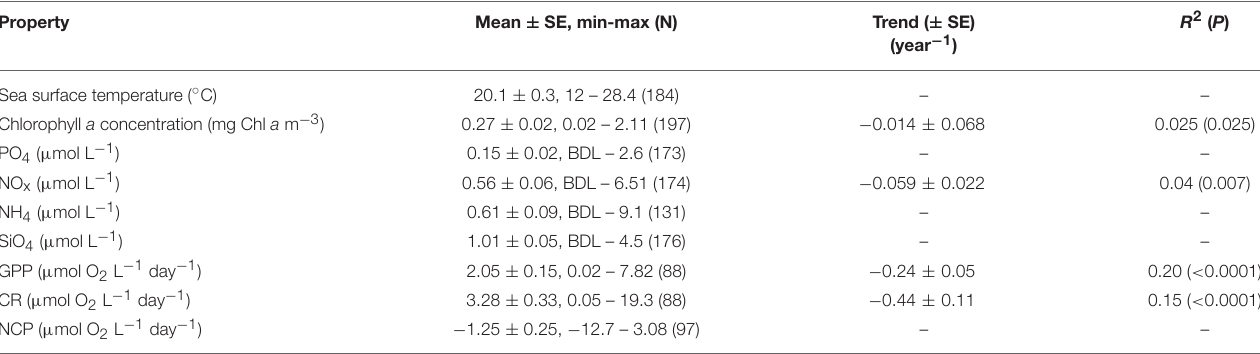
TABLE 1 | Mean ± SE, minimum, and maximum sea surface temperature, nutrient concentration, chlorophyll a concentration, gross primary production, community respiration, net community production, and the linear rates of change ( ± SE), along with the R 2 and probability of the observed linear trends, in Cap Salines coastal waters along the observation period (2006-2015).